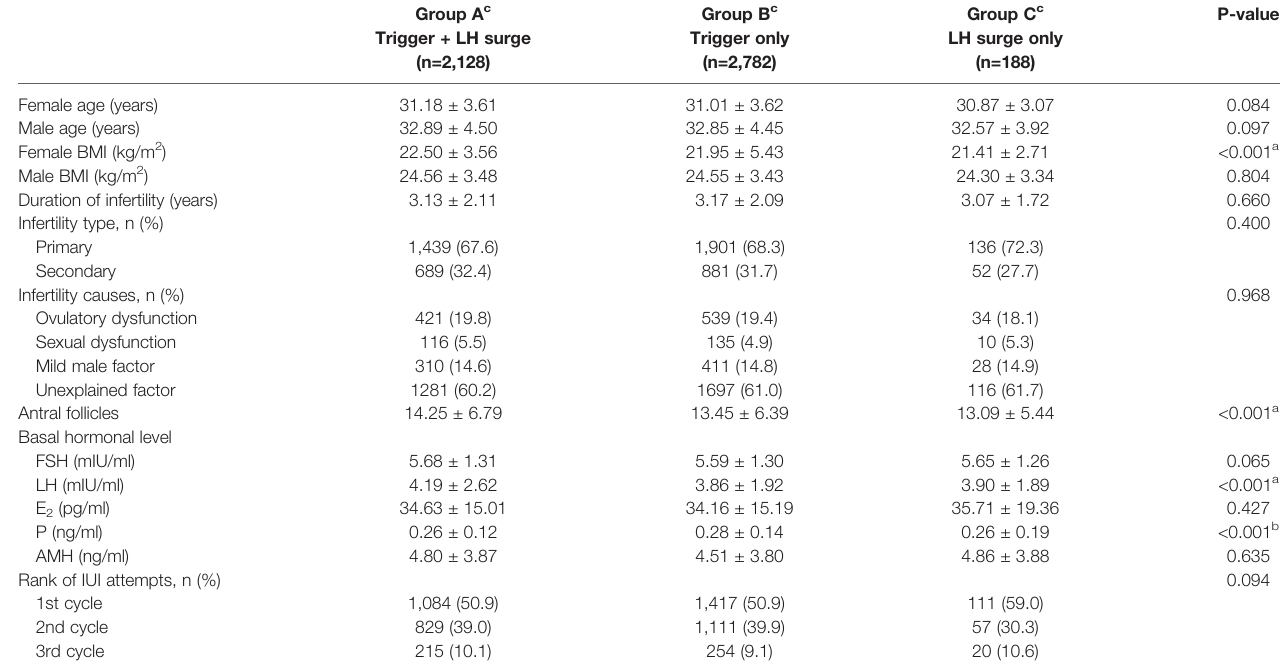
TABLE 1 | The demographic and basic characteristics of